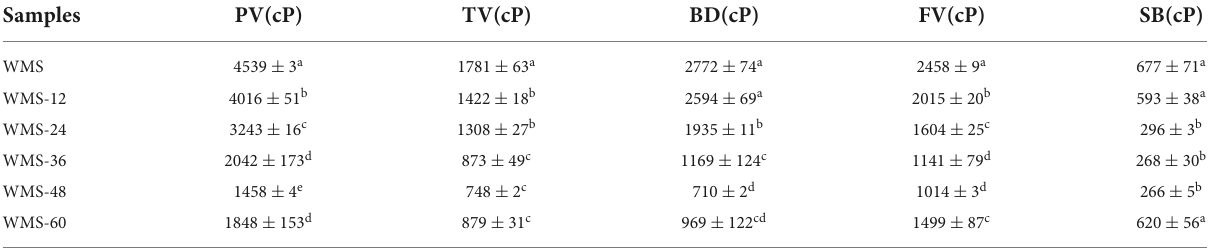
TABLE 4 The pasting properties of native and fermented